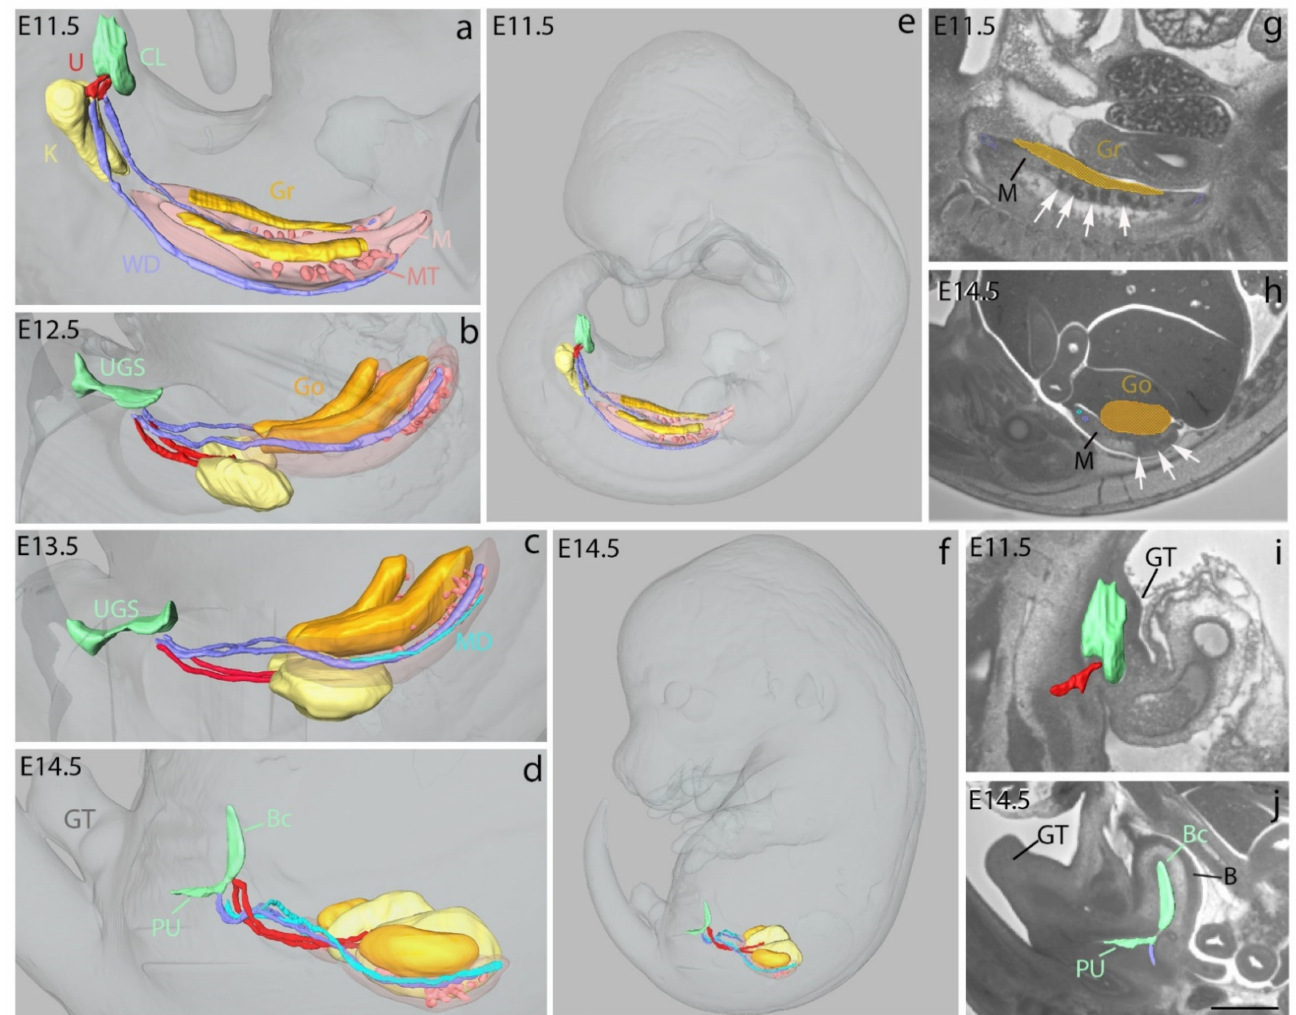
Figure 4. 3D representation of the developing urogenital system of mouse embryos. 3D representation of the urogenital system (in colors) and the external surface of the embryos (in shades of gray) at E11.5 ( a ), E12.5 ( b ), E13.5 ( c ) and E14.5 ( d ). Hindlimbs were removed to better visualize the genital tubercle (GT). 3D representation of urogenital system in a whole embryo at E11.5 ( e ) and E14.5 ( f ) to show the changes in topology and shapes during development. Segmentation of the genital ridge (E11.5), gonad (E14.5) (orange), mesonephric mesenchyme (M) and mesonephric tubules (MT) (white arrows) at E11.5 ( g ) and E14.5 ( h ). 3D representation of the urogenital sinus (UGS) and formation of bladder and ureters on sagittal HREM sections at E11.5 ( i ) and E14.5 ( j ). The genital tubercle (GT) is beginning to form at E11.5 and well developed at E14.5. The urogenital sinus comprises the pelvic urethra (PU) and urinary bladder (B) at E14.5 ( d , j ). K: metanephros (definitive kidney), Go: gonad, Gr: genital ridge, WD: Wolffian duct, MD: Müllerian duct, CL: lumen of cloaca, U: ureteric bud (E11.5) or ureters, Bc: urinary bladder cavity. Scale bar in ( j ): 150 µ m ( i , g ), 600 µ m ( j ), 850 µ m ( h